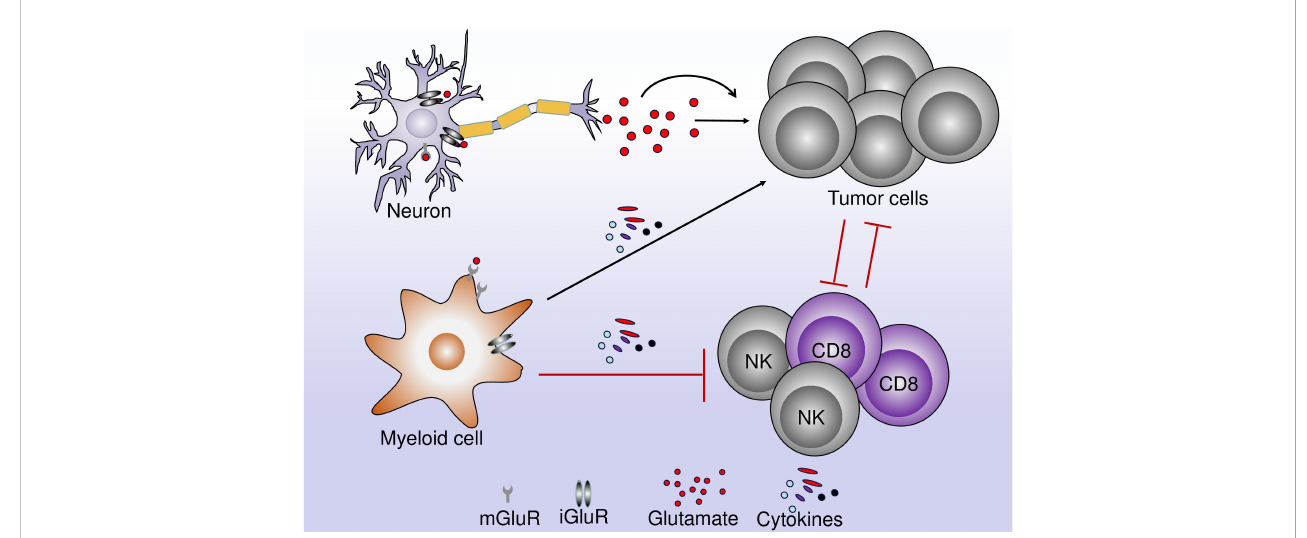
FIGURE 4 The role of glutamate in the interaction between neurons, immune cells, and tumor cells. A neuron can release neurotrophic factors and cytokines leading to the regulation of TME. These cytokines can act directly on tumor cells leading to their proliferation and tumor growth. Within the TME, immune cells and tumor cells interact together. Glutamate can bind to glutamate receptors on myeloid and lymphoid cells leading to an increase in the antitumor immune response or the inhibition of the antitumor immune